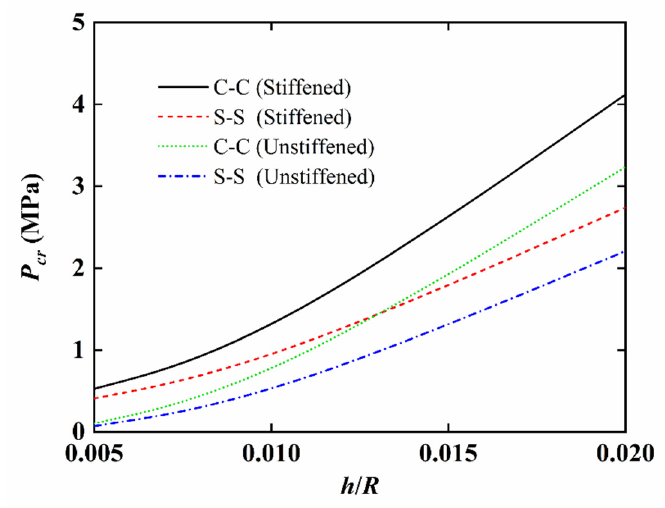
Figure 6. Variation in critical pressure of unstiffened and ring-stiffened porous GPLRC cylindrical shells with thickness–radius ratios.